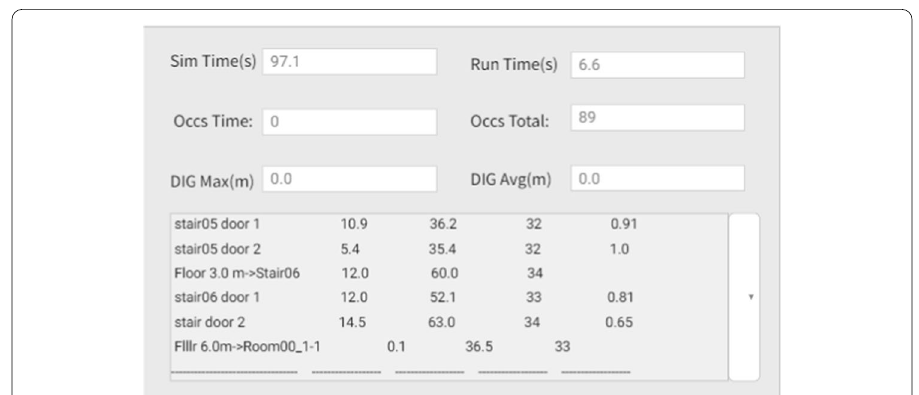
Fig. 5 BIM-based evacuation results for elderly in smart spaces